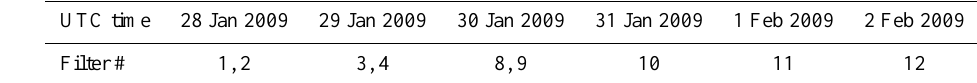
Table 2. The filters used for calculating the average FN concentrations based on the day of measurement.